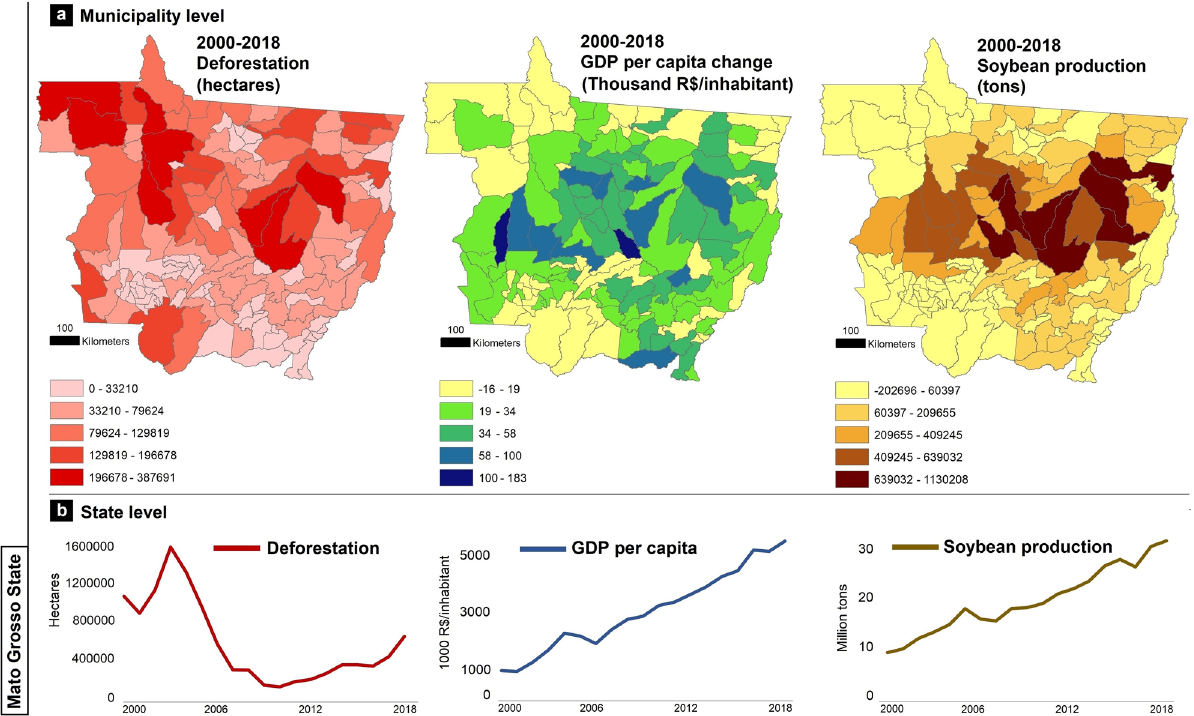
Figure 2. Dynamics of deforestation, Gross Domestic Product (GDP) per capita, and soybean production in Mato Grosso, Brazil, between 2000 and 2018. ( a ) Maps represent the changes observed between 2000 and 2018 in forest cover (i.e., deforestation), GPD per capita, and soybean production in each of the 141 municipalities comprising the state of Mato Grosso, Brazil. ( b ) Line graphs show the trends (2000–2018) of these